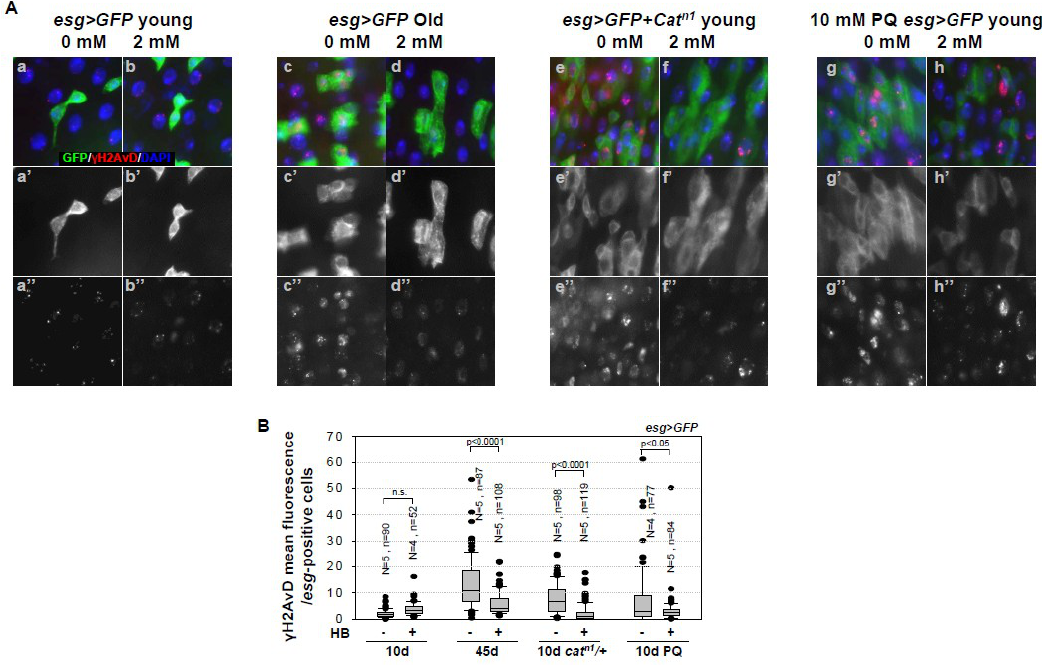
Figure 2. β -HB inhibits age- and oxidative stress-induced DNA damage accumulation in midgut intestinal stem cells (ISCs) and progenitors. ( A ) Guts from 10-day-old esg > GFP flies (a–b”), 45-day-old esg > GFP flies (c–d”), and 10-day-old esg > GFP + Cat n1 mutant flies (e–f”), without (a–a”, c–c”, e–e”) or with (b–b”, d–d”, f–f”) 2 mM β -HB feeding for seven days, were stained with anti- γ H2AvD (red), anti-GFP (green), and DAPI (blue). Ten-day-old esg > GFP flies, without (g–g”) or with (h–h”) 2 mM β -HB feeding for six days, were treated with 10 mM PQ in standard media for 20 h, after which their guts were stained with anti- γ H2AvD (red), anti-GFP (green), and DAPI (blue). a’, b’, c’, d’, e’, f’, g’, and h’ indicate enlarged GFP stained images. a”, b”, c”, d”, e”, f”, g”, and h” indicate enlarged γ H2AvD stained images. Original magnification is 400 × . ( B ) Graph showing the average fluorescence intensity of γ H2AvD in GFP-positive cells in 10-day-old esg > GFP , 45-day-old esg > GFP , 10-day-old esg > GFP + Cat n1 mutant, and 10-day-old PQ-treated esg > GFP flies, with or without β -HB feeding for seven days. N is the number of observed guts and n is the number of observed cells. The error bar represents standard error. p -values were calculated using Student’s t -test. n.s. indicates not significant ( p > 0.05).